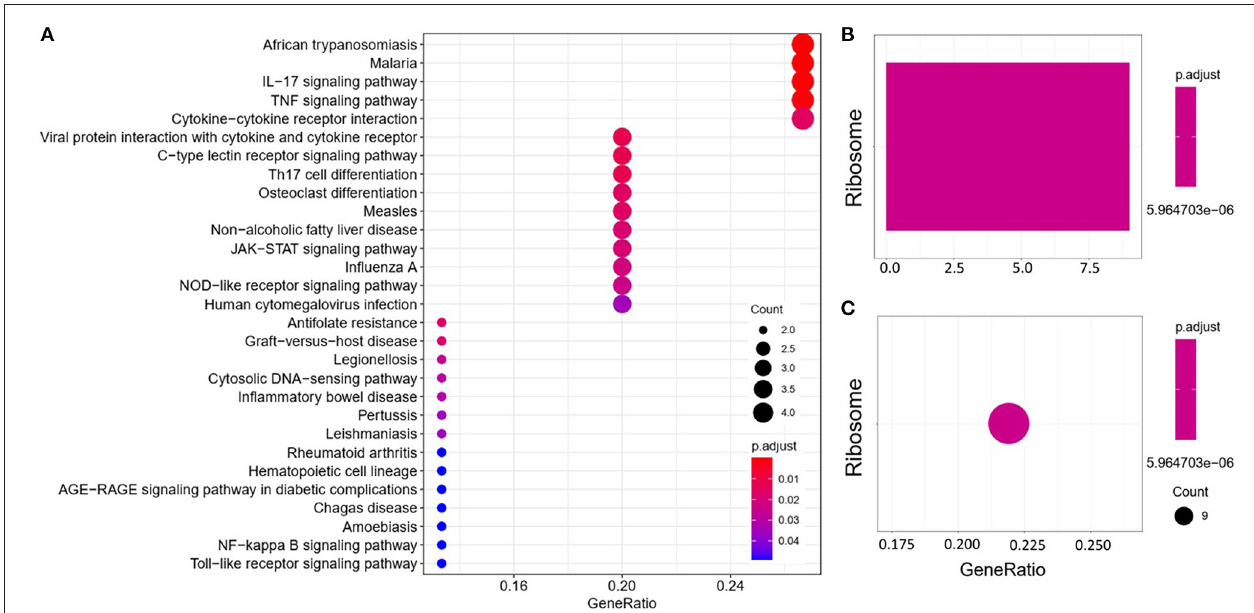
FIGURE 4 | Kyoto Encyclopedia of Genes and Genomes (KEGG) analyses of the upregulated (A) and downregulated (B,C) differentially expressed genes (DEGs) between abdominal aortic aneurysm (AAA) and health control